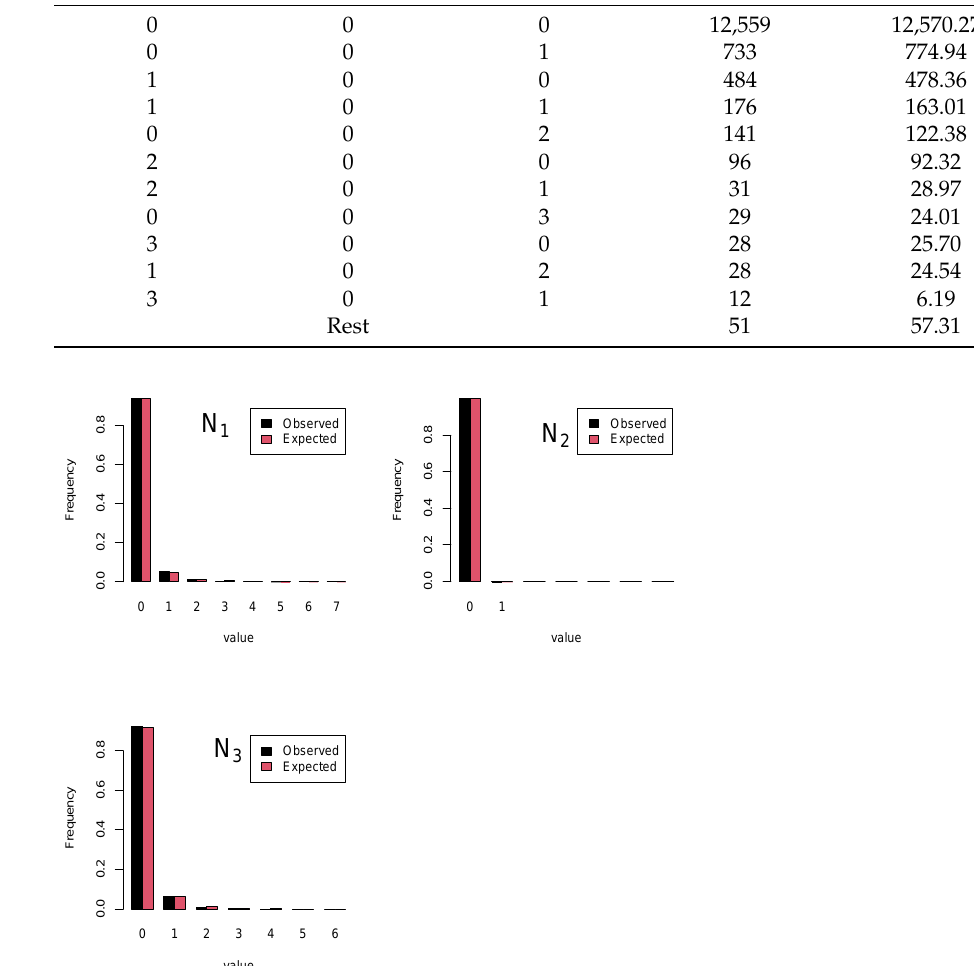
Table 4. Observed and expected frequencies for the most frequent triplets n 1 , n 2 , n 3 . The fit is satisfactory. We obtain χ 2 = 14.382 and p -value = 0.2125. n 1 n 2 n 3 Observed